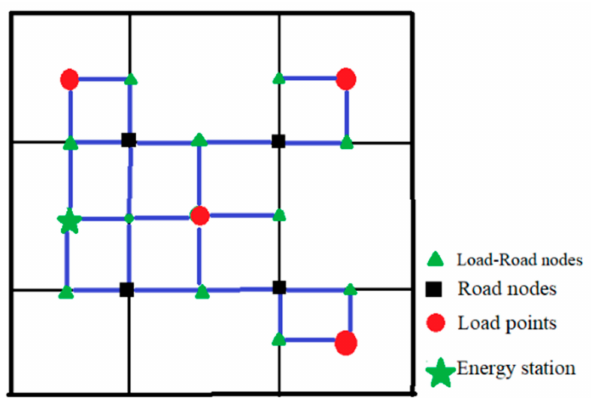
Figure 4. A schematic of the connected graph G using the Point-to-Point model.